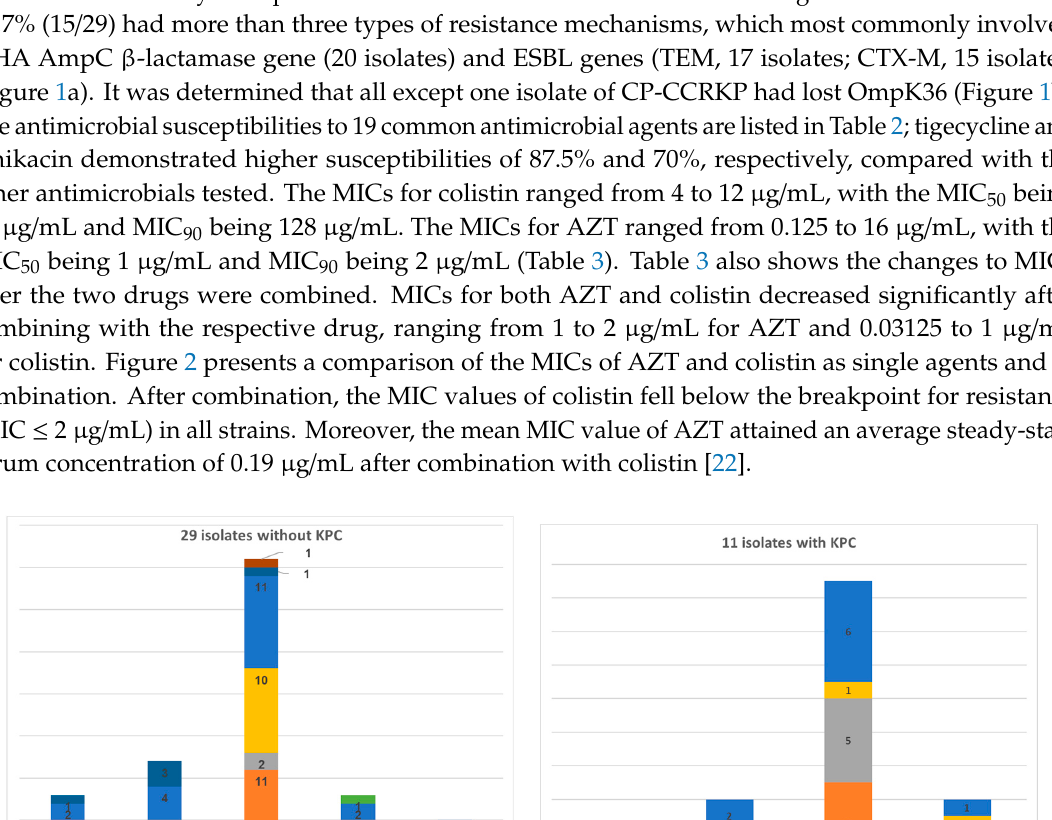
Table 3. MIC range, MIC 50 , MIC 75 , and MIC 90 for colistin, AZT, and colistin/AZT combination.